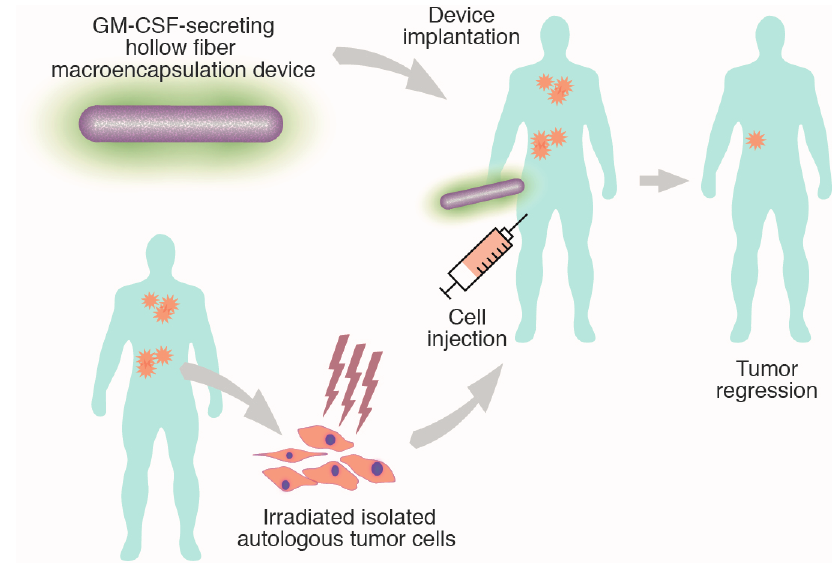
Figure 4. Therapeutic autologous tumor cells vaccination using granulocyte-macrophage stimulating-factor (GM-CSF)-expressing encapsulated cells as a strong